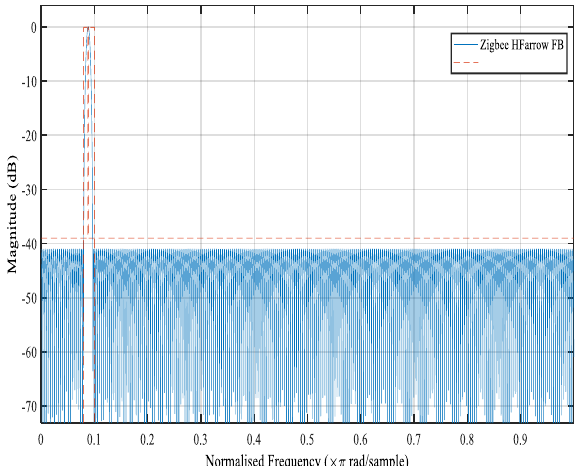
Figure 8. Magnitude response for the Zigbee masking filter using the HFarrow